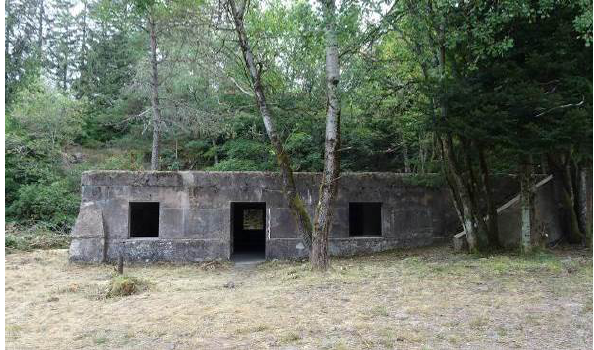
Figure 5 : View of the southwest façade of the